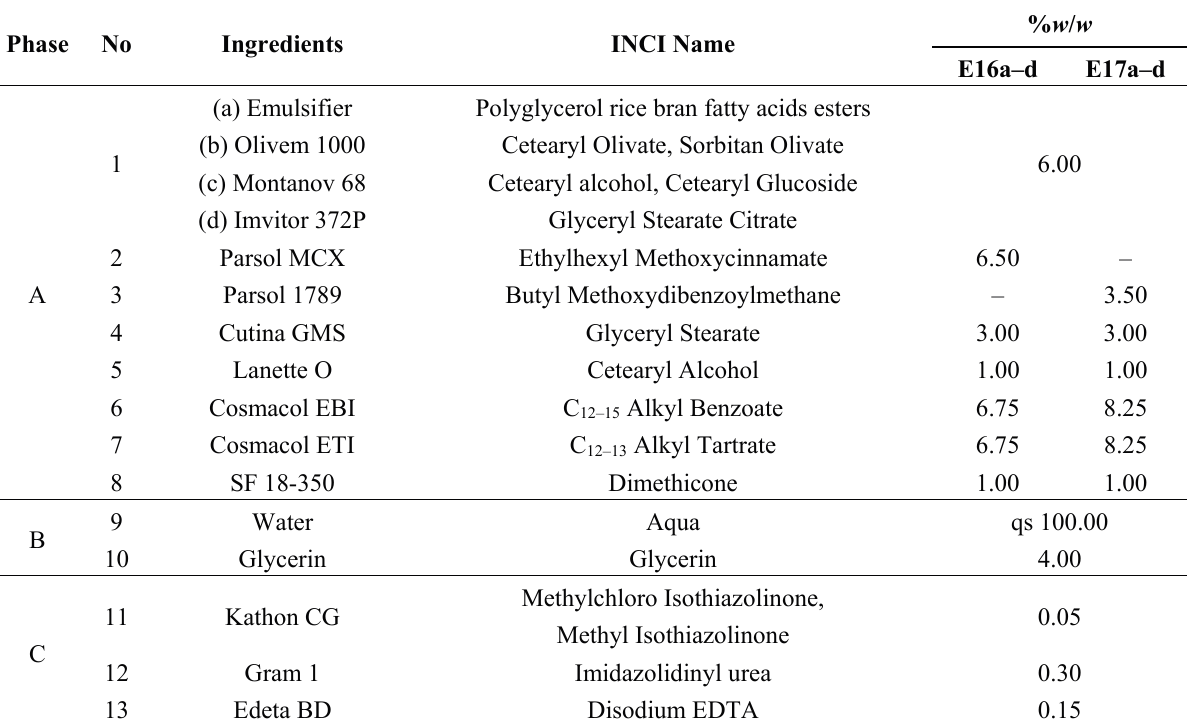
Table 6. Compositions of O/W emulsions containing UVB (E16a–d) and UVA (E17a–d) filters prepared with different